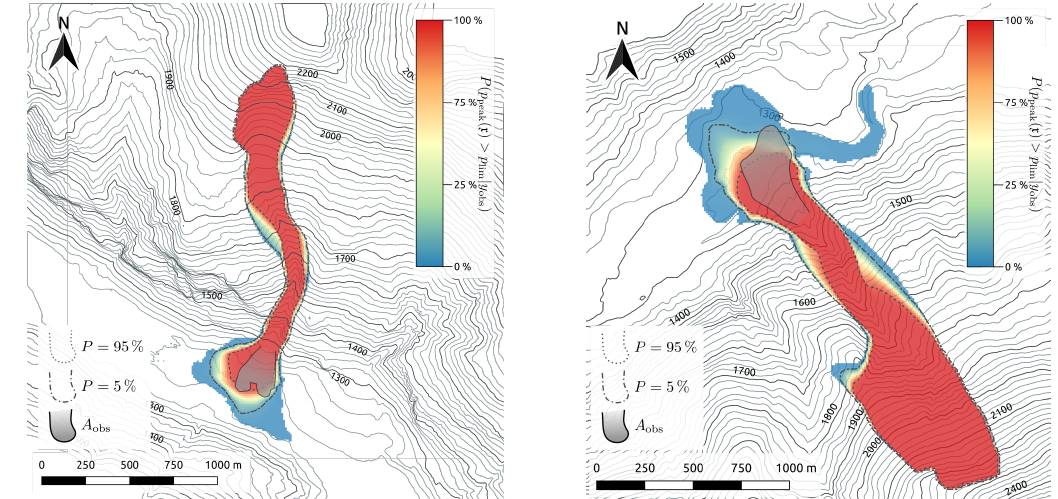
Figure 4. Visualization of the conditional probability P ( p peak ( x ) > p lim | y obs ) for the forward calculations (left, Kerngraben avalanche) and predictive simulations (right, Wolfsgruben avalanche) with the Monte Carlo sample θ pred . The observed affected area A obs is shown as reference for the true post positive ( tp ) and false positive f p values in the runout area (black shading, solid line). The color map indicates the probability P ( p peak ( x ) > p lim | y obs ) , that a respective area of the simulation raster is affected by an avalanche, given the considered data. The P = 95% and P = 5% probability isolines are highlighted (dotted and dashed-dotted lines), allowing to identify areas that exceed the threshold peak pressure p peak ( x ) > p lim in most simulation runs (dark red) or outliers that appear with probabilities P < 5% (light